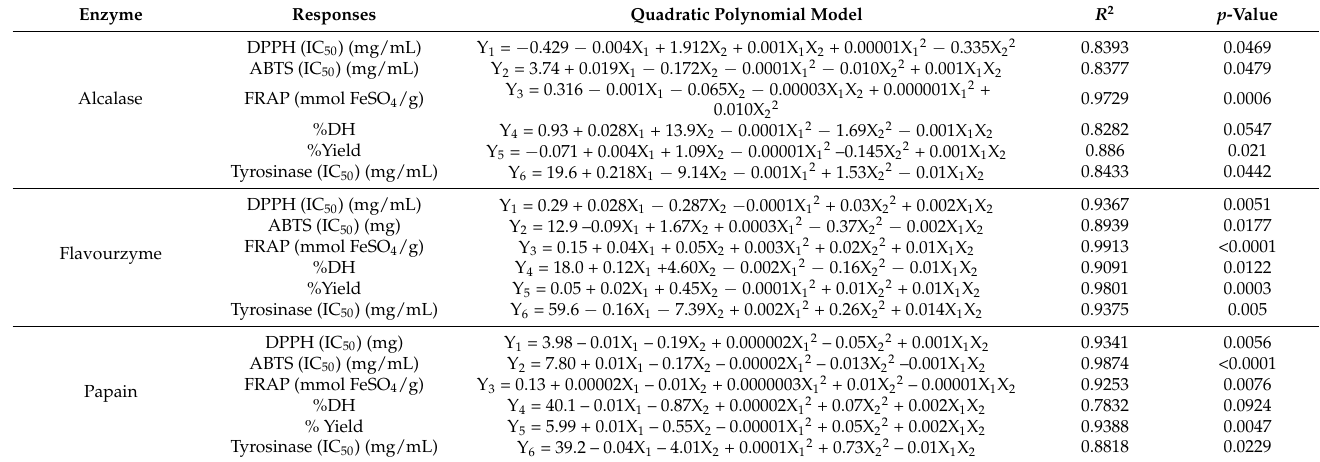
Table 2. Full quadratic model of jellyfish hydrolysis using alcalase, flavourzyme, and